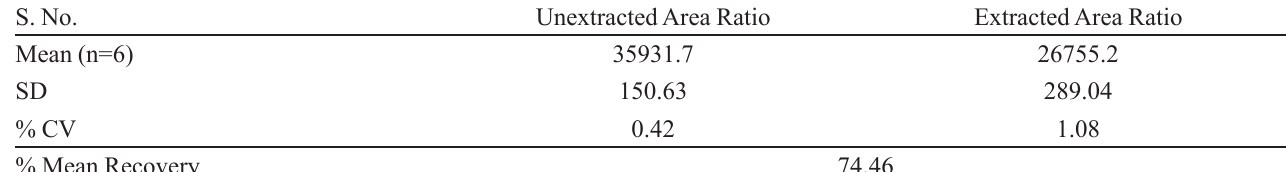
TABLE IX - Recovery of internal standard